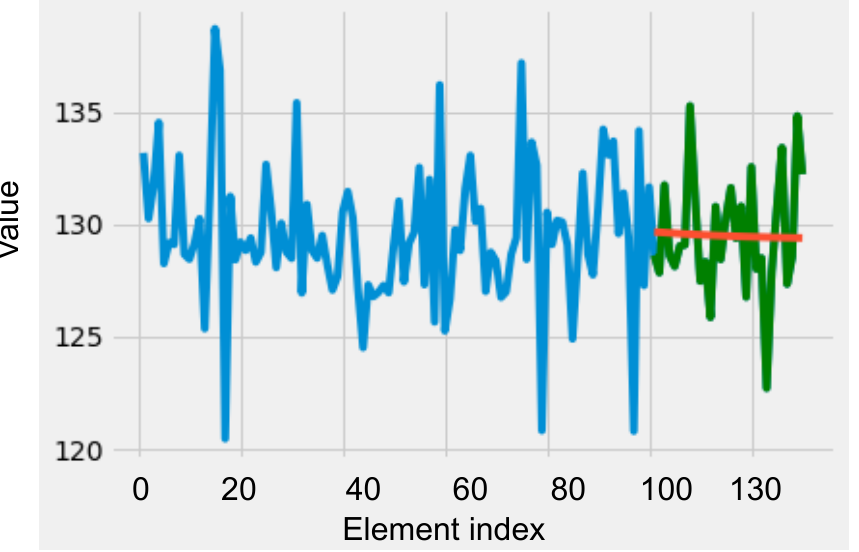
Figure 15. Comparing the prediction with the expected